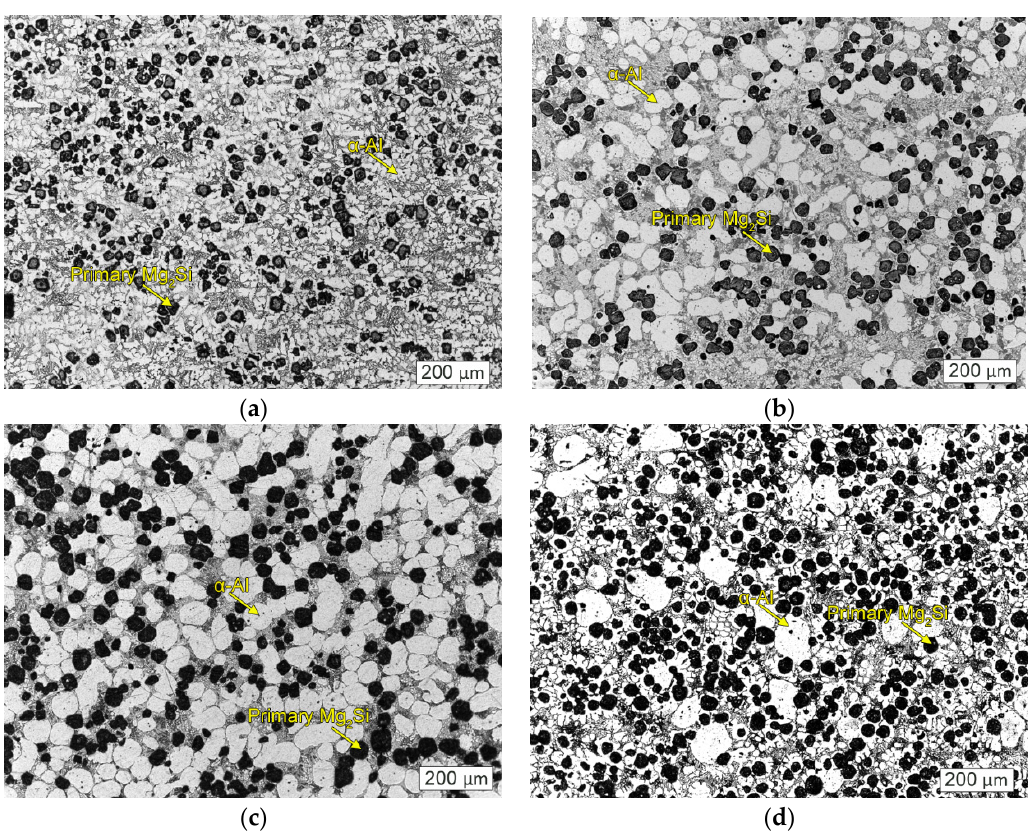
Figure 1. Microstructures of Mg 2 Si–Al composites fabricated by using ( a ) gravity casting and semi-solid extrusion with isothermal heat treatment holding times of ( b ) 50 min, ( c ) 60 min, and ( d ) 160 min.